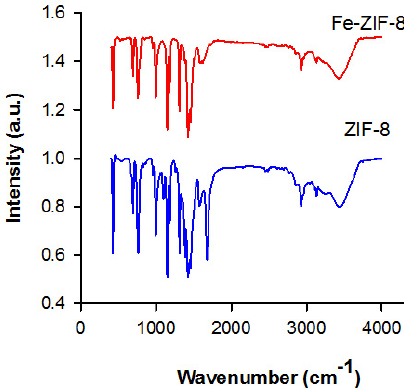
Fig. 3. FTIR spectrum of the ZIF-8 and Fe-ZIF-8 nanocatalysts.